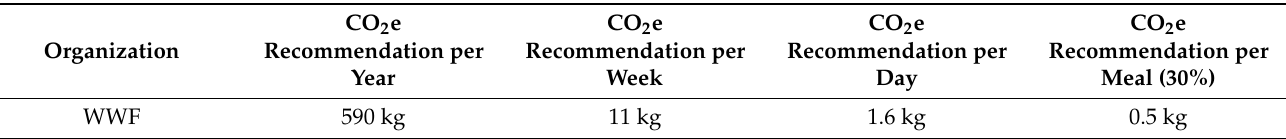
Table 2. Reference values for CO 2 e recommendations per year, week, day and meal, the latter corresponding to 30% of the recommended daily intake [44]. WWF: World Wildlife